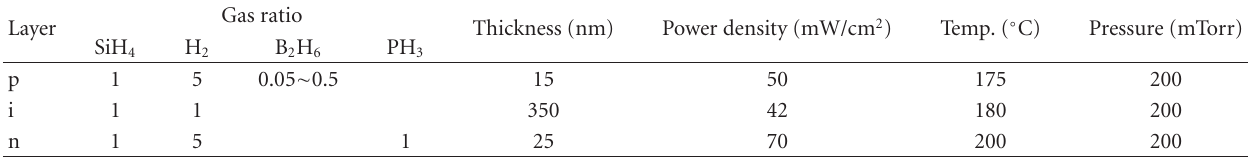
Table 2: Deposition condition of solar cell layers.